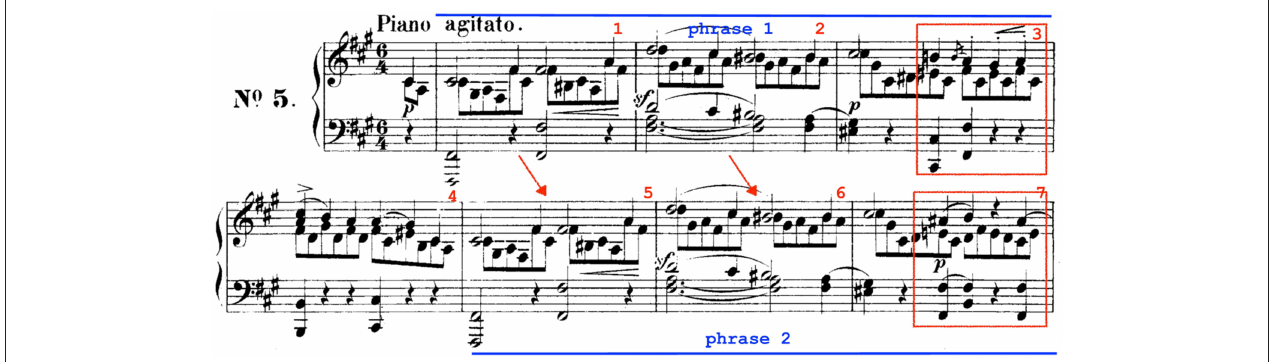
FIGURE 7 | The figure shows the beginning of Mendelssohn’s Song without words Op. 19 No. 5. The excerpt contains two musical phrases (bars 1–4 and 5–7) that have highly regular structure; indeed, bars 1 and 5 and bars 2 and 6 are the, respectively, equal while the only differences are in the ending part of bars 4 and 7. This type of musical regularity is very common in classical and romantic